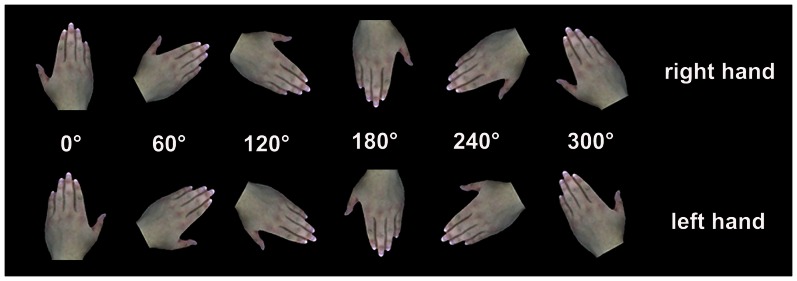
Stimulus used in the mental transformation test.